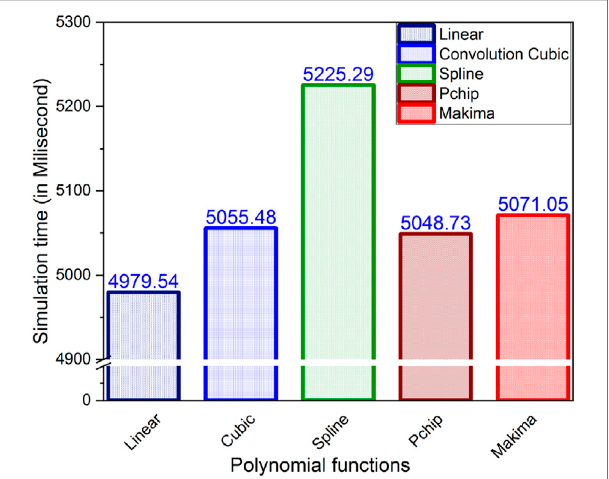
FIGURE 7 | Simulation time of different interpolating